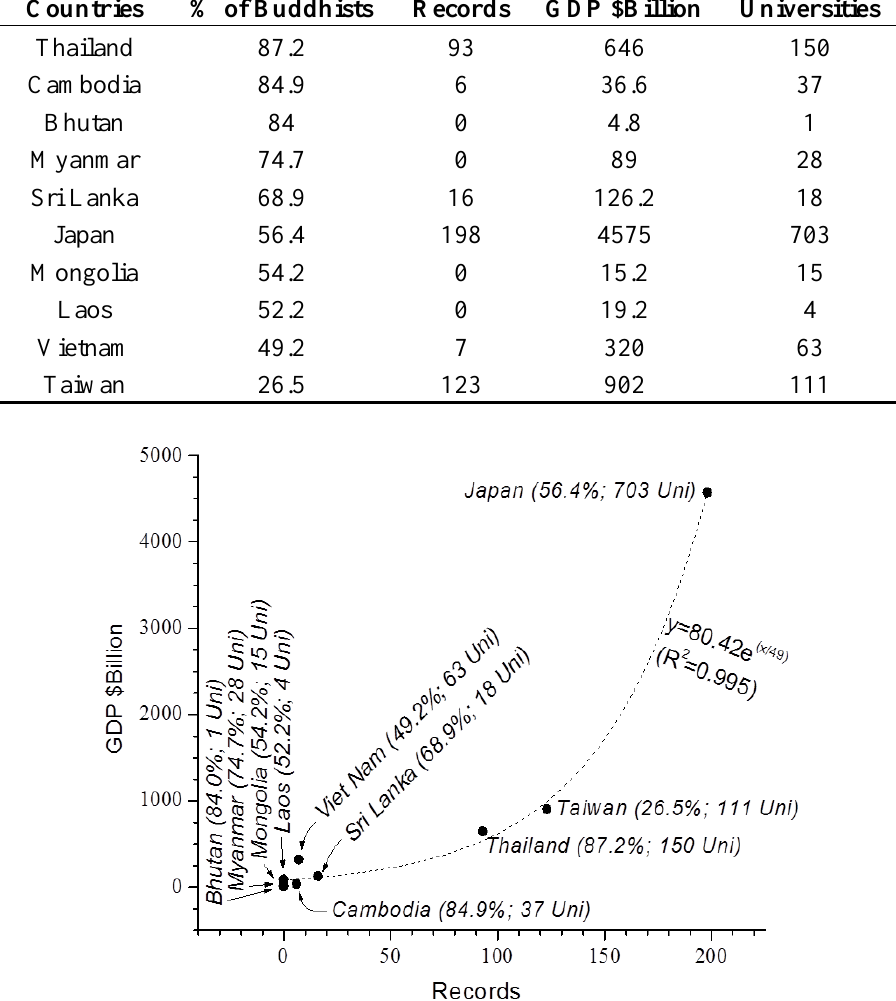
Figure 2. Correlation between GDP and number of publications in the field of Buddhism and Buddhist studies for the top 10 countries with the highest percentage of Buddhists amongst the population [7]. Percentage of Buddhists (%) and number of universities (Uni) in each country are given in